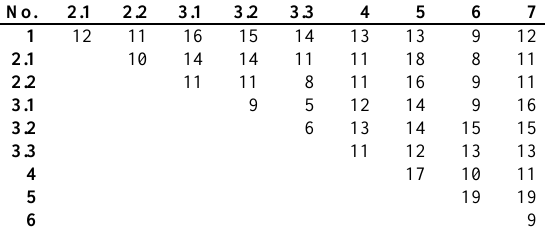
Table 8. Dissimilarity measure between any two clusters.